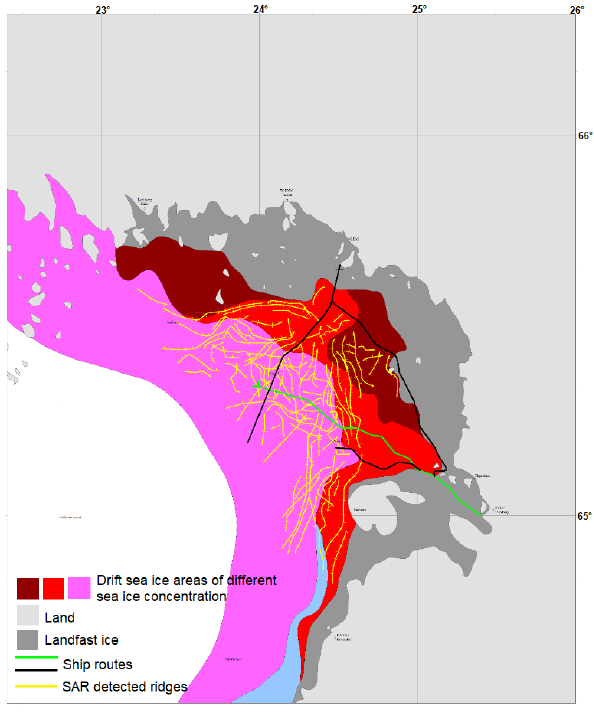
Figure 10. Ridges close to the ports of Oulu and Kemi, winter 2013/14. Courtesy of the FIS and Finnish Transport Infrastructure Agency. Note that only the ridges falling within the area of ship channels (black and green lines) were